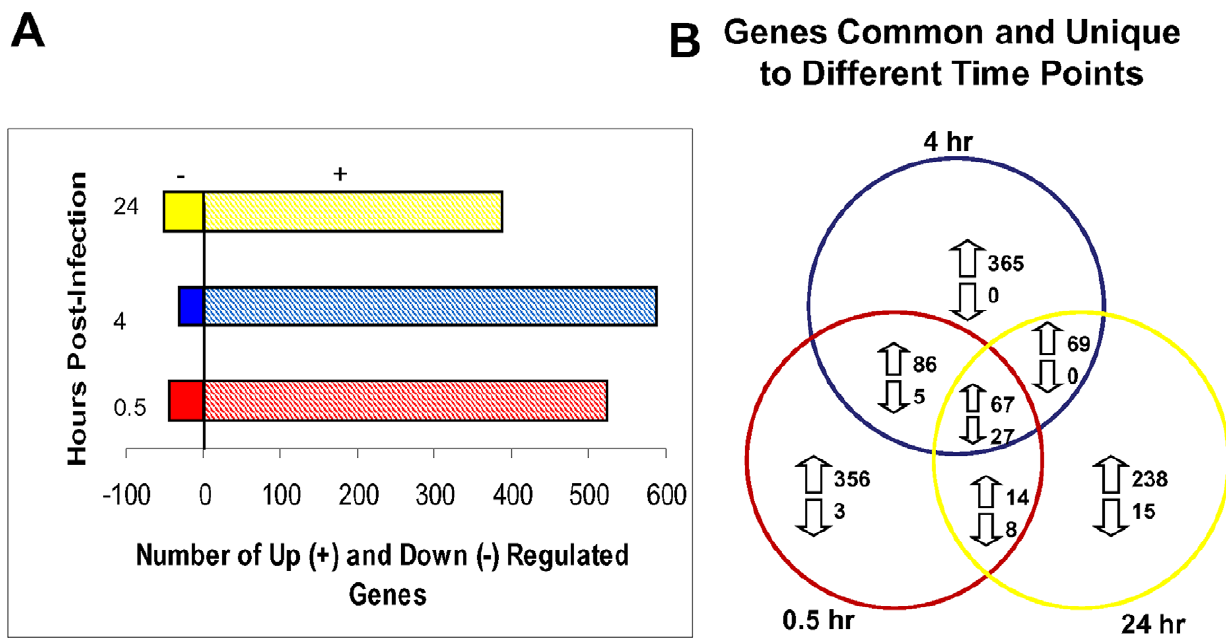
Figure 1. Variation of up- and down-regulated transcripts with time post-infection. A) The number of gene transcripts up- or down- regulated at 0.5, 4 and 24 hours post-infection/interaction with Leishmania (Viannia) panamensis promastigotes are schematically summarized. The decreasing response of the up-regulated gene transcripts with time is evident; the number of down-regulated genes is relatively consistent across the time points. B) The numbers of gene transcripts in common or differentially expressed at each time point. Gene transcript expression comparisons were made between infected and uninfected macrophages for each individual at the different time points. Gene transcripts with average intensity values less than 2 6 background intensity for both comparison groups, or fold change less than 1.5 fold (up or down-regulated) were excluded in further statistical analysis. A paired t test using p-value cutoff 0.05 was applied to determine if a gene was statistically differentially